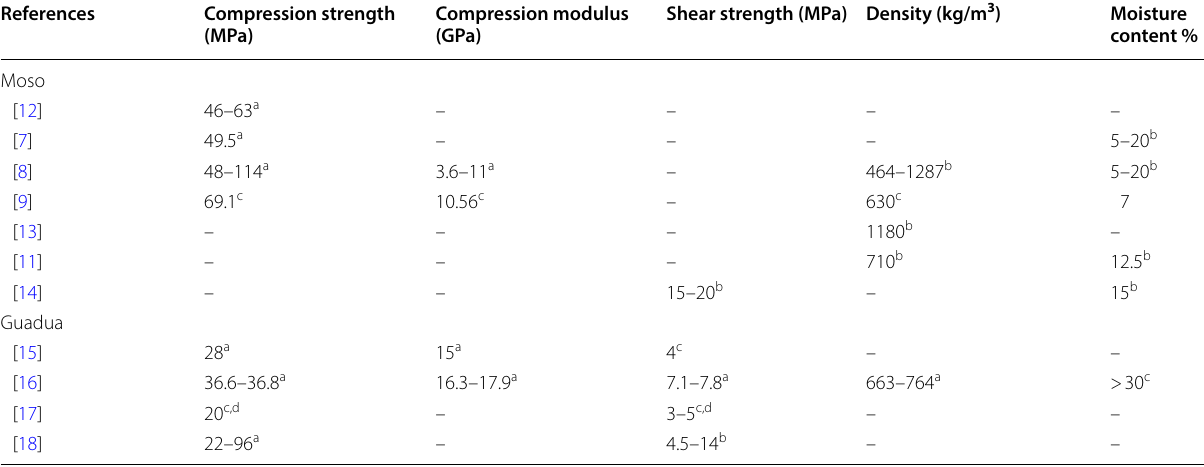
a Based on full-size samples b Based on clear samples c Other